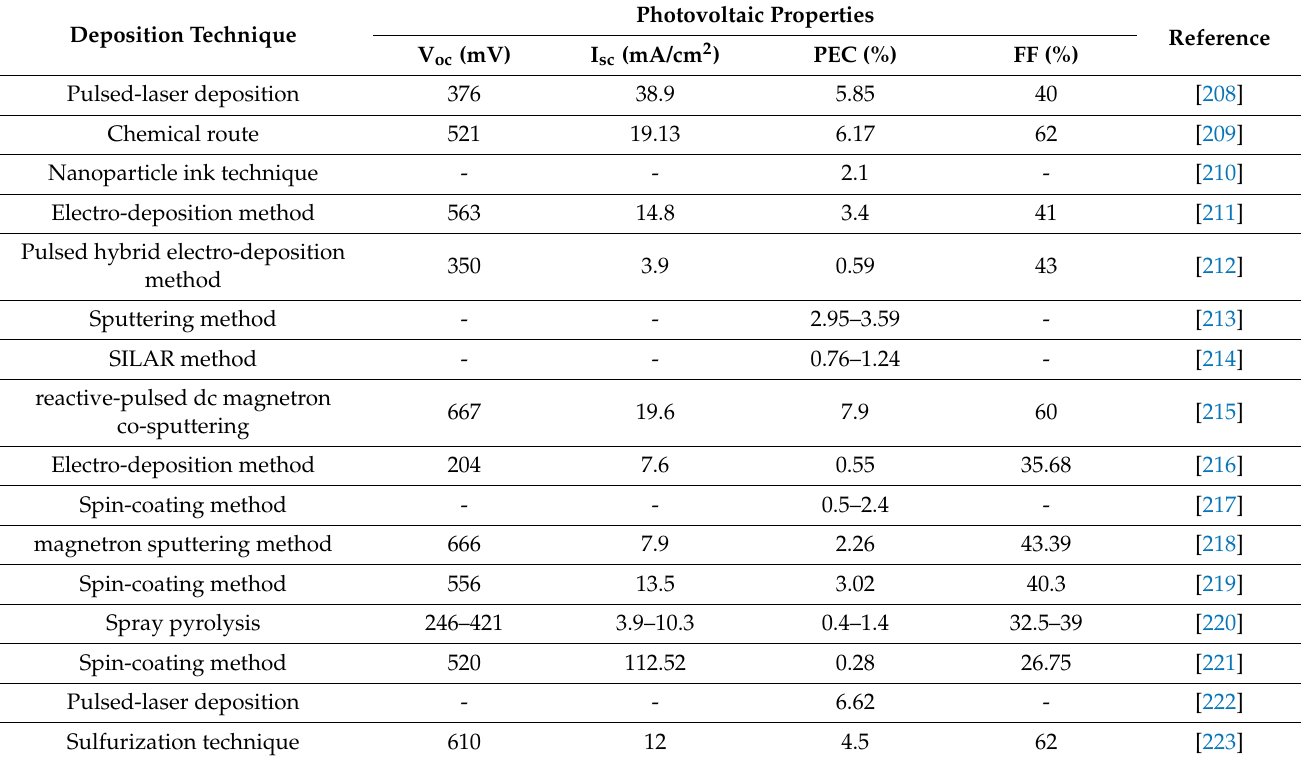
Figure 12. Crystal structures of ( a ) stannite and ( b ) kesterite [207]. Table 4. The growth of CZTS films using various deposition methods and the photovoltaic proper- ties.